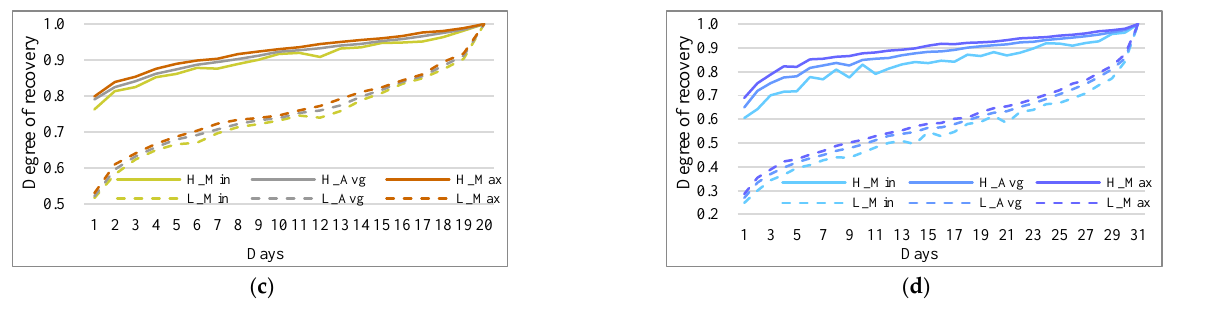
Figure 15. The degree of representation of high- and low-travel structures and flows. ( a ) Travel spatial structure in Shenzhen. ( b ) Travel spatial structure in New York. ( c ) Travel flow in Shenzhen. ( d ) Travel flow in New York.